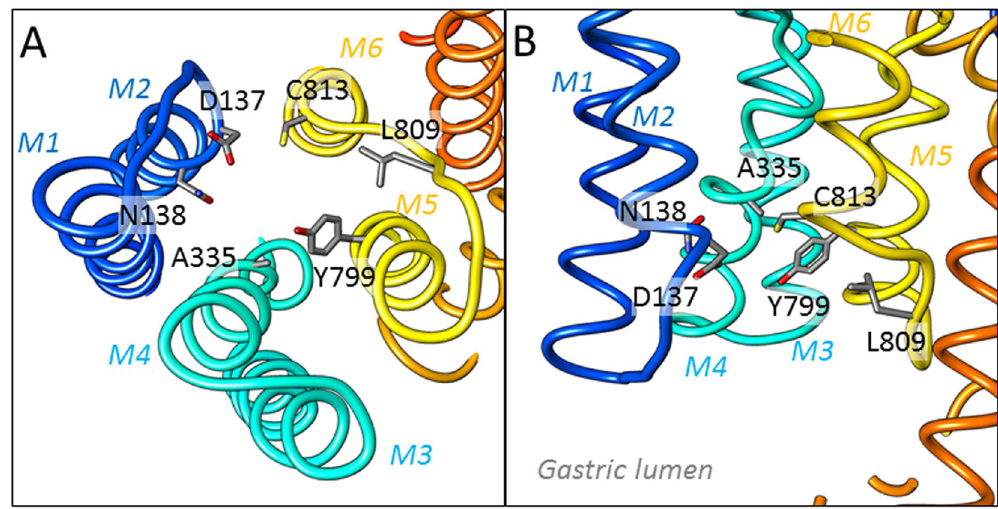
Figure 3. Model of the P-CAB binding site on H + ,K + -ATPase. Closed view of the luminal cavity region in the homology model of H + ,K + -ATPase (ribbons, colours are as in Fig. 2), viewed from luminal side of the membrane ( A ) and parallel to the membrane normal ( B ). Amino acids important for P-CAB binding determined by present and previous mutagenesis studies are shown as stick